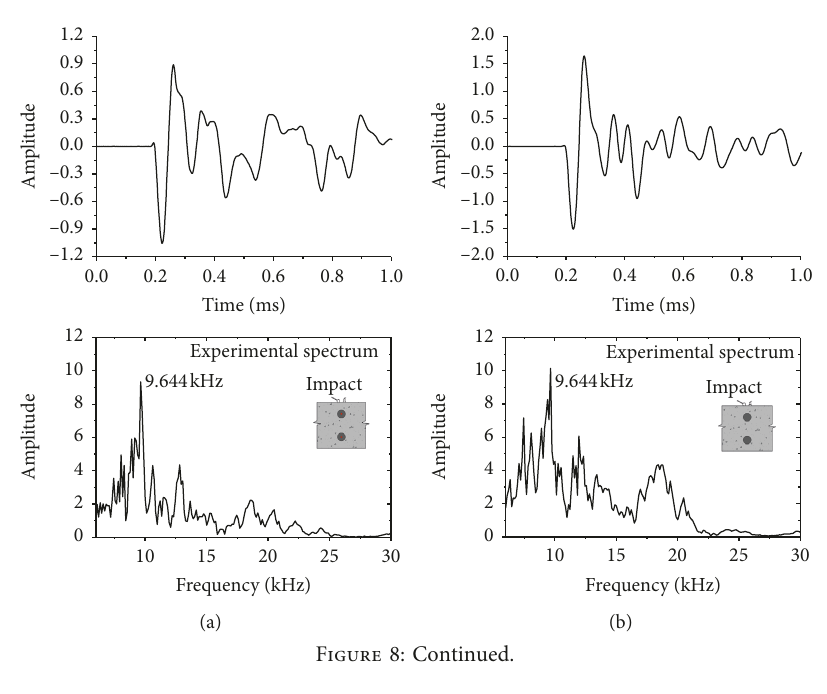
Figure 7: Test scheme.